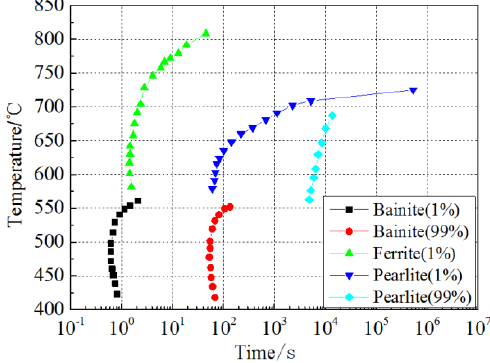
Figure 3. The time-temperature transformation (TTT) curve of USIBOR ® 1500 high-strength steel. Combined with the CCT curve drawn by Xing [16], in order to ensure the maximum martensite